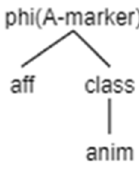
Figure 21. After insertion of v*, inheritance, Agree, and labeling. 30.